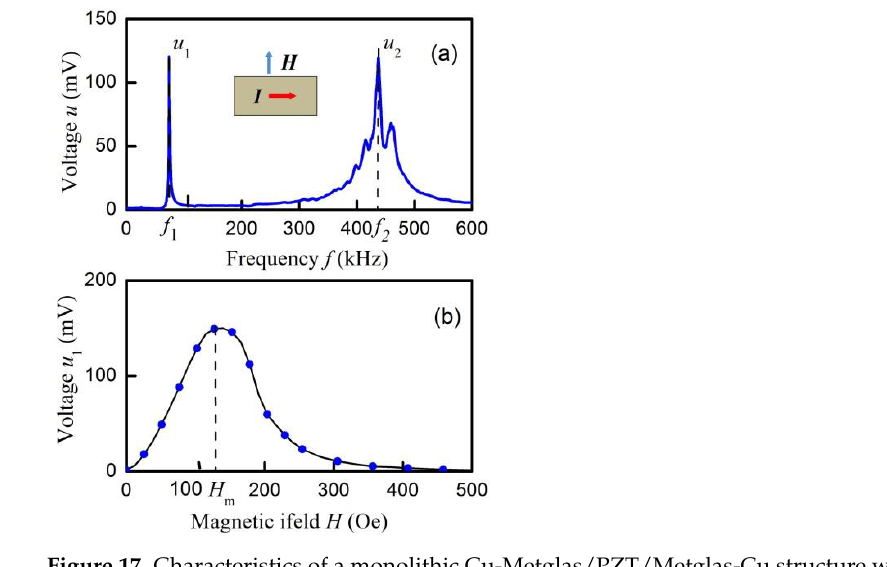
Figure 17. Characteristics of a monolithic Cu-Metglas/PZT/Metglas-Cu structure with integrated excitation system at H ⊥ I ; ( a ) ME voltage u vs. frequency f for H = 134 Oe; ( b ) ME voltage u 1 vs. field H for f = 73.3 kHz.